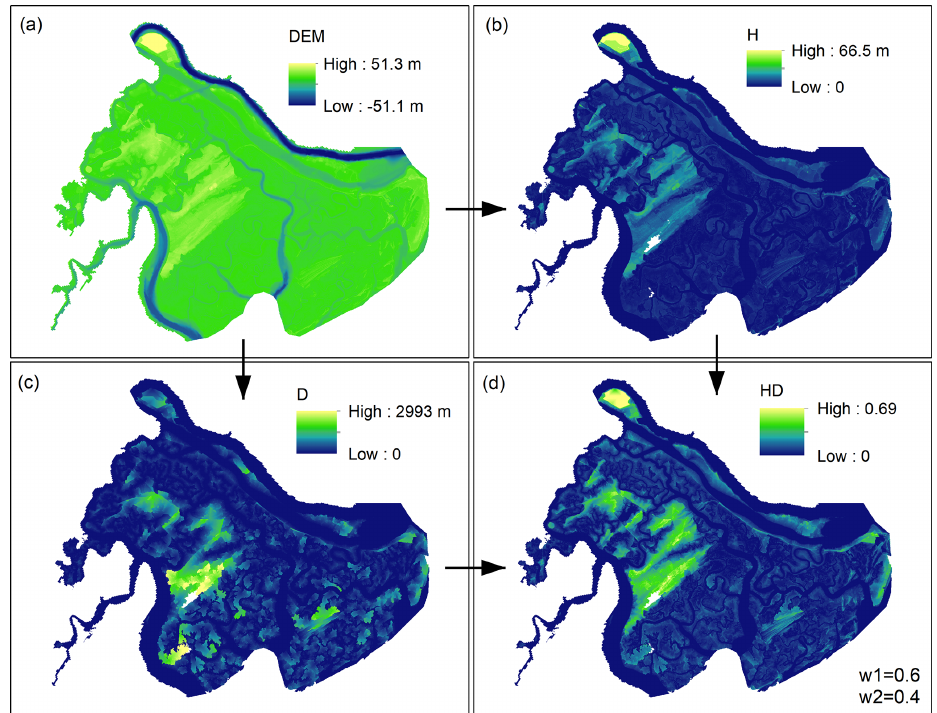
Figure 3. The required steps for calculating the proposed hydrogeomorphic index. A high-resolution coastal DEM (3m) is used as the source data (a) to generate the height above nearest drainage ( H ) and the distance to the nearest drainage ( D ) ( b and c , respectively). Using Eq. (1), the normalized features H and D are multiplied with different weights to generate the I HD index (d)